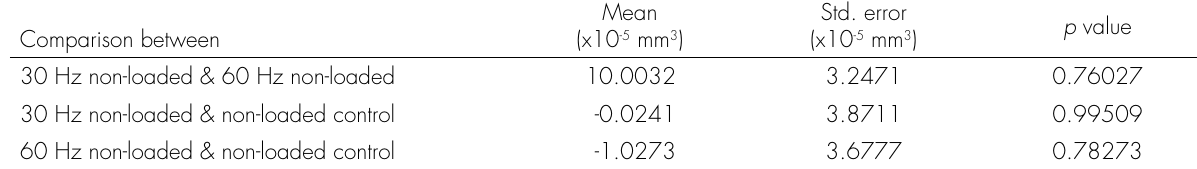
Comparison between